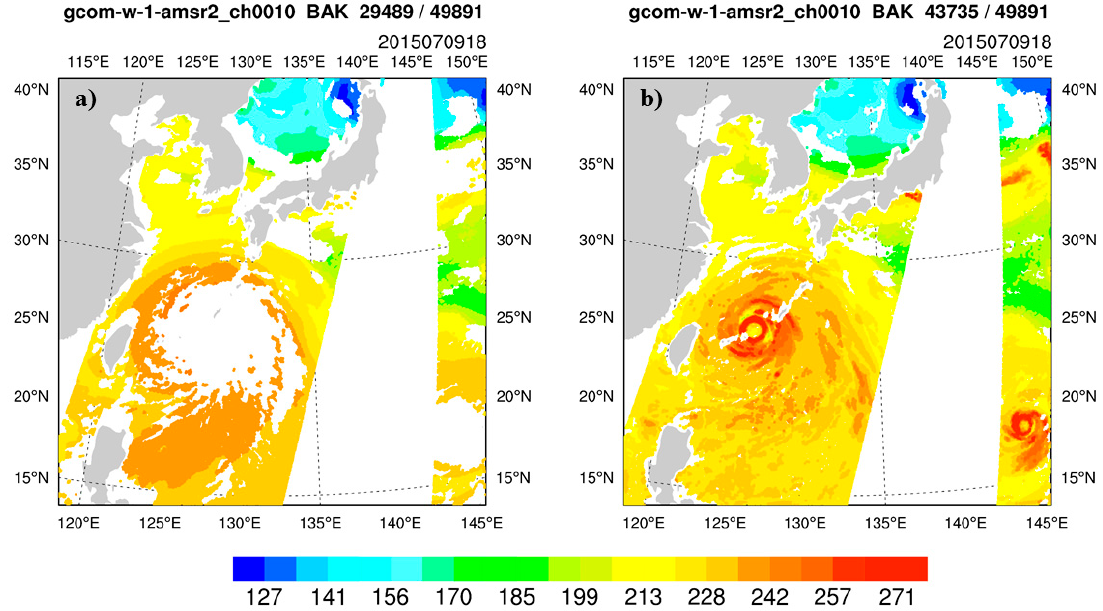
Figure 2. Brightness temperature simulation for AMSR2 channel 10 after ( a ) clear-sky quality control and ( b ) all-sky quality control.